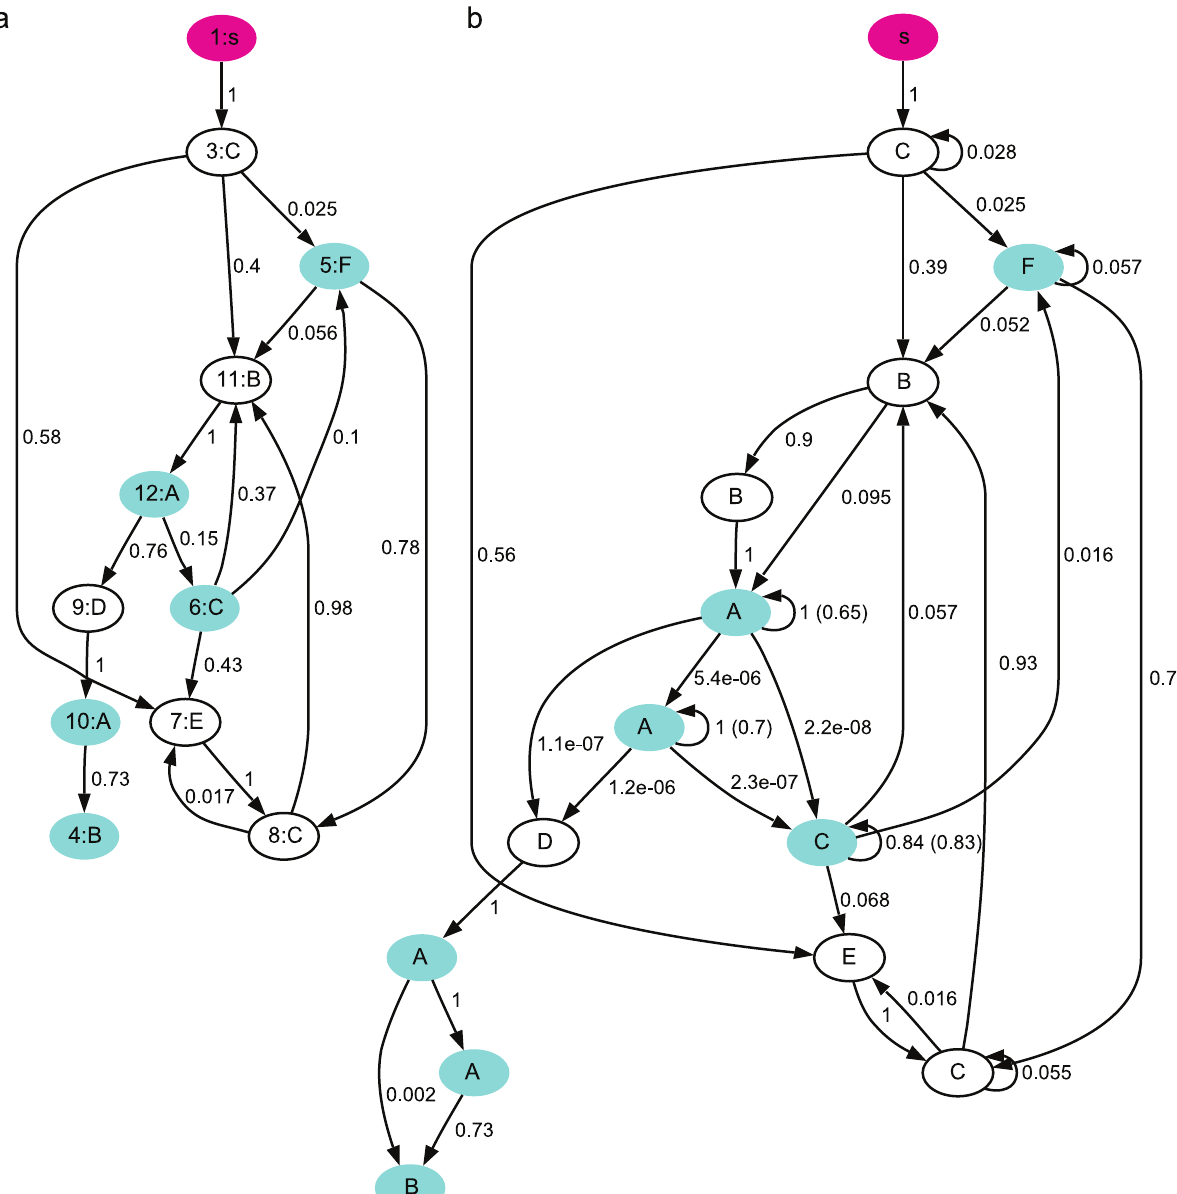
Figure 9. The POMMA (Bird 2). a . The POMM derived from the observed syllable sequences with syllable repetitions taken out. The numbers in the ovals are the state labels. b . The POMMA derived from the model shown in a with the repetitions fitted with adaptation models. The convention is the same as in Figure 2.